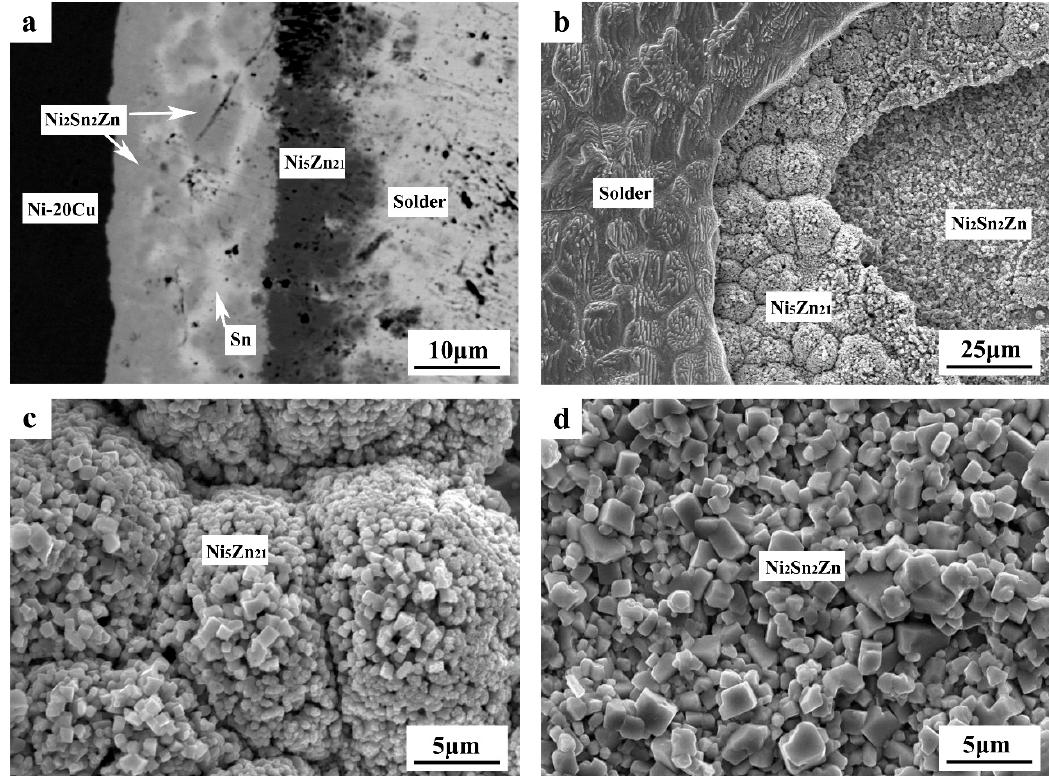
Figure 2. The Sn-Zn/Ni-20Cu joint of 16 h soldering at 250 °C: ( a ) cross-section micrograph; ( b ) Etched interface; ( c ) morphology of Ni 5 Zn 21 grains; ( d ) morphology of Ni 2 Sn 2 Zn grains.